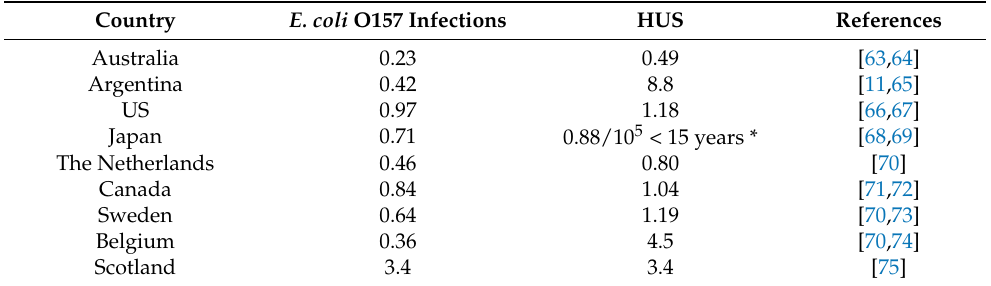
Table 1. Incidence of E. coli O157 infections per 100,000 inhabitants and HUS per 100,000 children under 5 years of